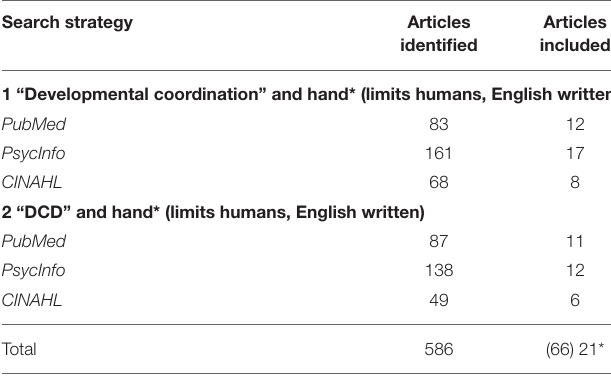
TABLE 1 | Description based search and